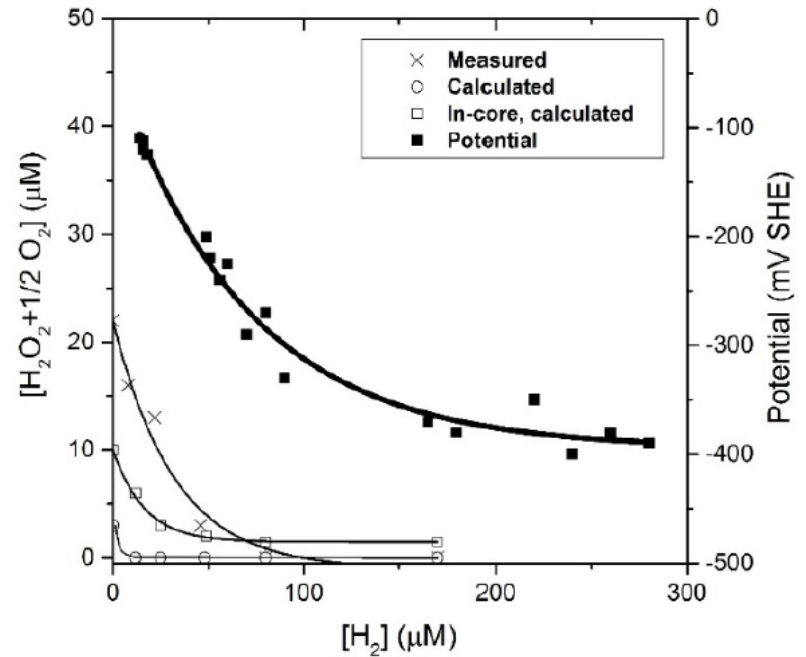
Figure 27. Oxidant concentration and the ECP of stainless steel at 150 °C, as a function of inlet hydrogen concentration as measured in Studsvik’s INCA in-reactor loop (after Christensen et.al. [28]). © 1996 ITER Organization. This image is hereby used courtesy of the ITER Organization.